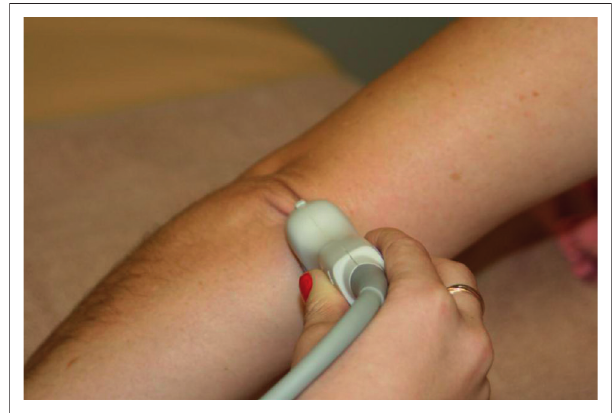
Source : T. Roodt. FIGURE 7: Transducer position for a transverse section of the ulnar nerve at the level of the cubital tunnel with the elbow in extension. The medial aspect of the transducer (side of the marker) was placed at the medial epicondyle and the lateral aspect of the probe on the